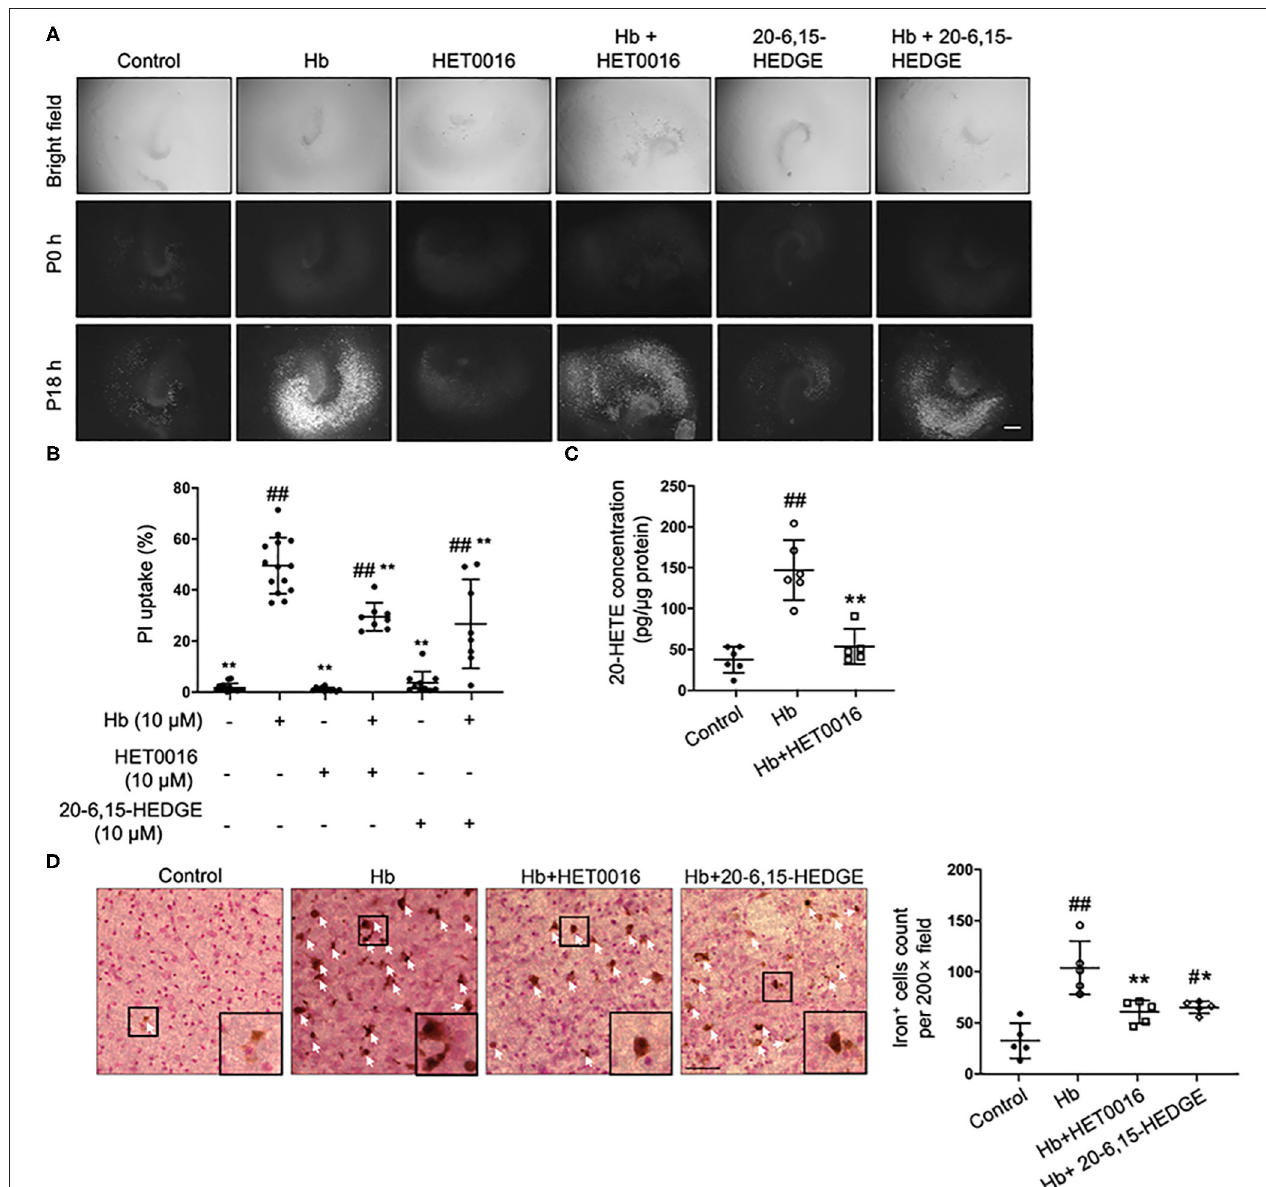
FIGURE 1 | 20-HETE participates in hemoglobin (Hb)-induced cell death in organotypic hippocampal slice cultures (OHSCs). (A) OHSCs were exposed to 10 µ M Hb. HET0016 (10 µ M), a 20-HETE synthesis inhibitor, or 20-6,15-HEDGE (10 µ M), a 20-HETE antagonist, was added along with Hb for 18h. OHSCs treated with HET0016 or 20-6,15-HEDGE alone and a vehicle-treated group served as controls. Propidium iodide (PI) staining was performed before (P0h) and 18h after (P18h) reagent treatment. Scale bar is 500 µ m. (B) Quantification of (A) . Cell death was evaluated as PI uptake percentage. Hb-induced cell death was significantly lowered by both HET0016 and 20-6,15-HEDGE. n = 8–14 slices/group. (C) Hb significantly increased 20-HETE content in OHSC lysates at 18h, but HET0016 prevented this increase. n = 5–6 from more than 25 slices per group. (D) OHSCs were exposed to Hb with or without HET0016 or 20-6,15-HEDGE for 18h, after which iron deposition was assessed. Representative images are shown along with examples of iron-positive cells at high magnification (insets). Arrows indicate iron-positive cells. Scale bar is 50 µ m. Both HET0016 and 20-6,15-HEDGE significantly reduced Hb-induced iron accumulation. n = 5 slices/group. # P < 0.05, ## P < 0.01 vs. Control group; * P < 0.05, ** P < 0.01 vs. Hb group. One-way ANOVA followed by appropriate post hoc test was applied. Data are expressed as mean ±